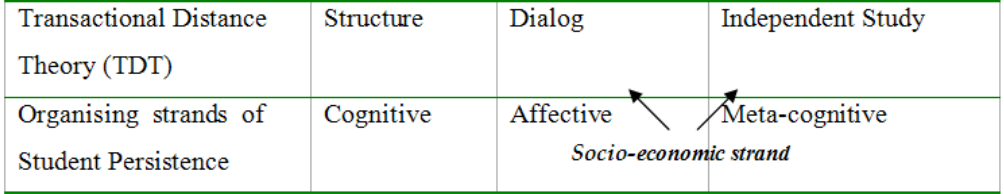
Table 2. Braiding Moore’s TDT and Deschênes’ organising strands of student